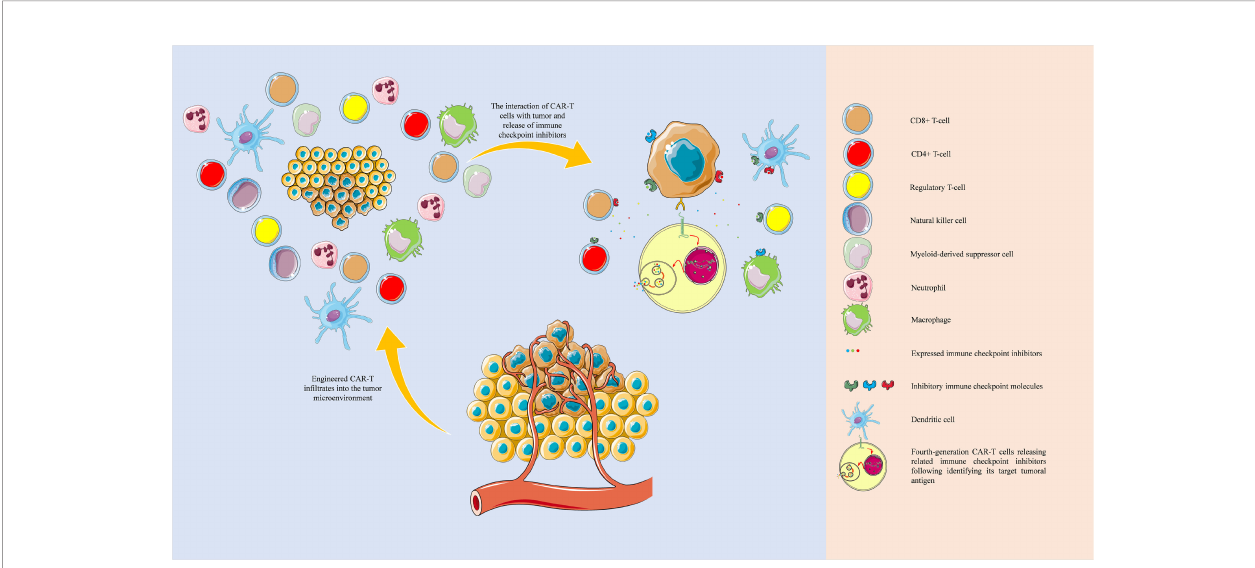
FIGURE 6 | Tumor microenvironment and single-cell sequencing-guided fourth-generation CAR-T cells. The development of fourth-generation CAR-T cells based on the single-cell sequencing-identi fi ed patient-derived neoantigens and the single-cell sequencing-guided inhibitory immune checkpoint molecules pro fi ling can potentially eradicate tumoral sub-populations and effectively attenuate inhibitory immune checkpoint network present in the tumor microenvironment. The objects of this fi gure were obtained from